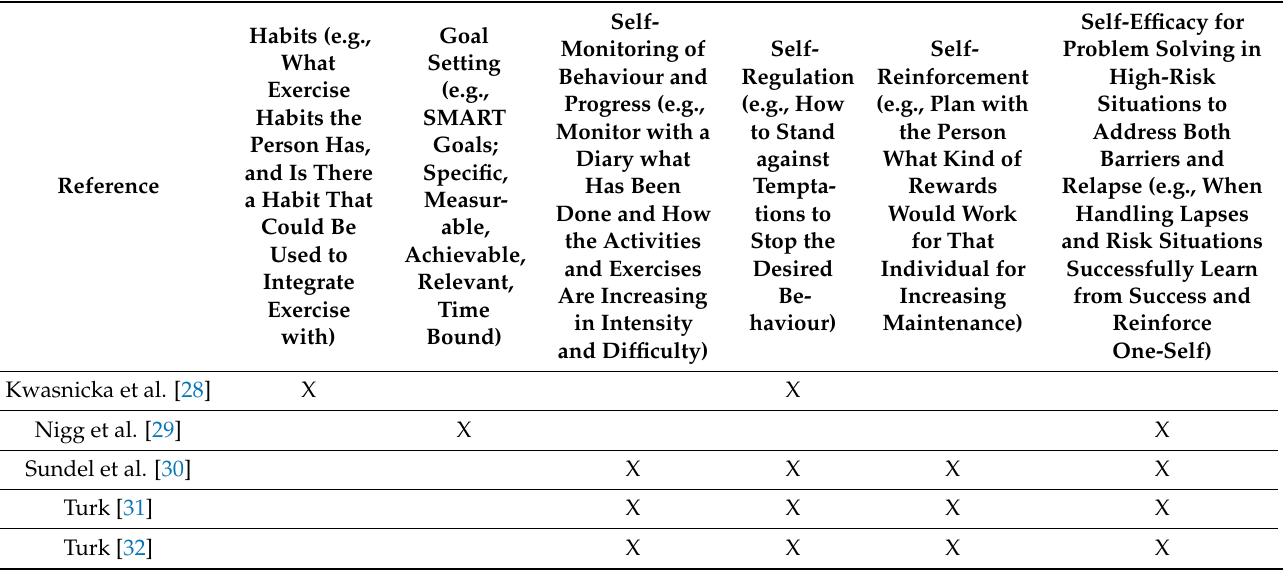
Table 7. Maintenance of behavioural change components categorized according to the behavioural wheel presented by Michie et al. [42] regarding capability, motivation and opportunity. Motivation: Motivation includes cognitive, emotional, and reflective decision making as well as habitual processes facilitating and directing behaviour/activity.